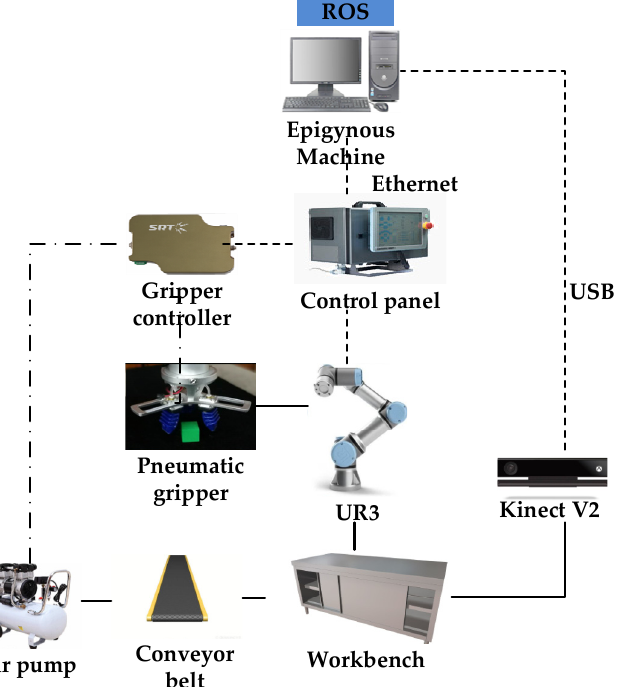
Figure 2. Dynamic tracking crawling experiment platform. The Kinect V2 depth camera collects the color image and depth image of the